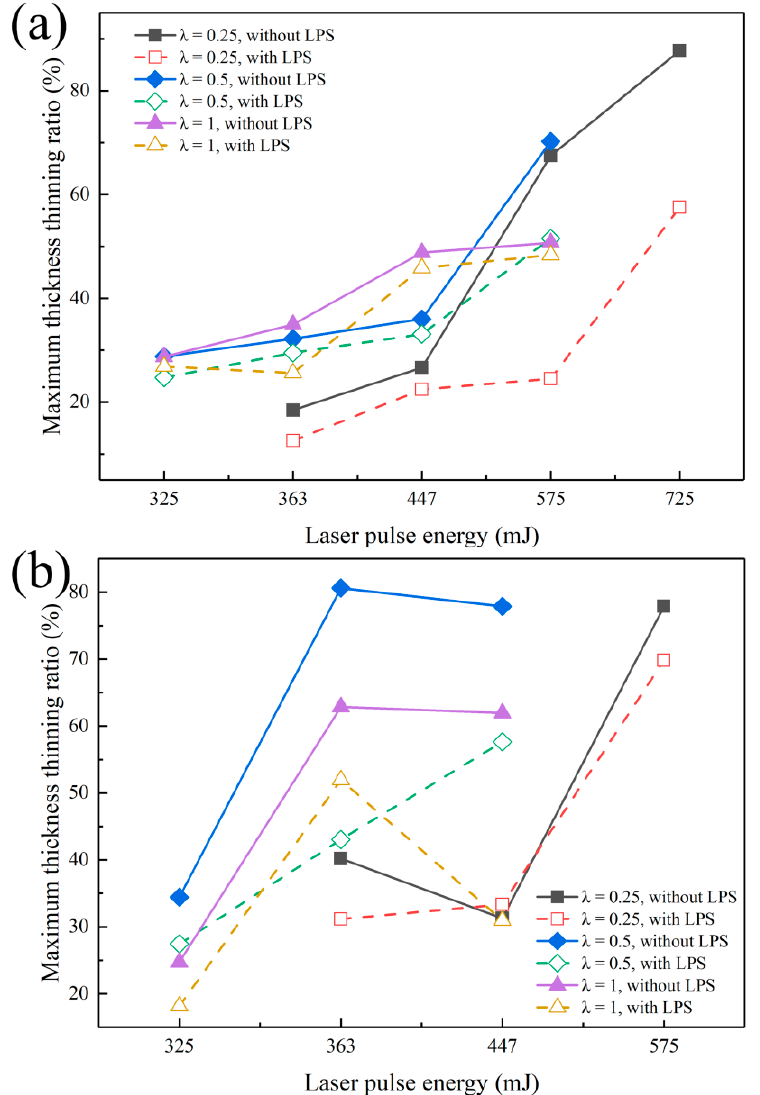
Figure 14. Maximum thickness thinning rate of bulging samples with different molds. ( a ) Fine ‐ grained samples (450 °C annealed); ( b ) coarse ‐ grained samples (650 °C annealed).